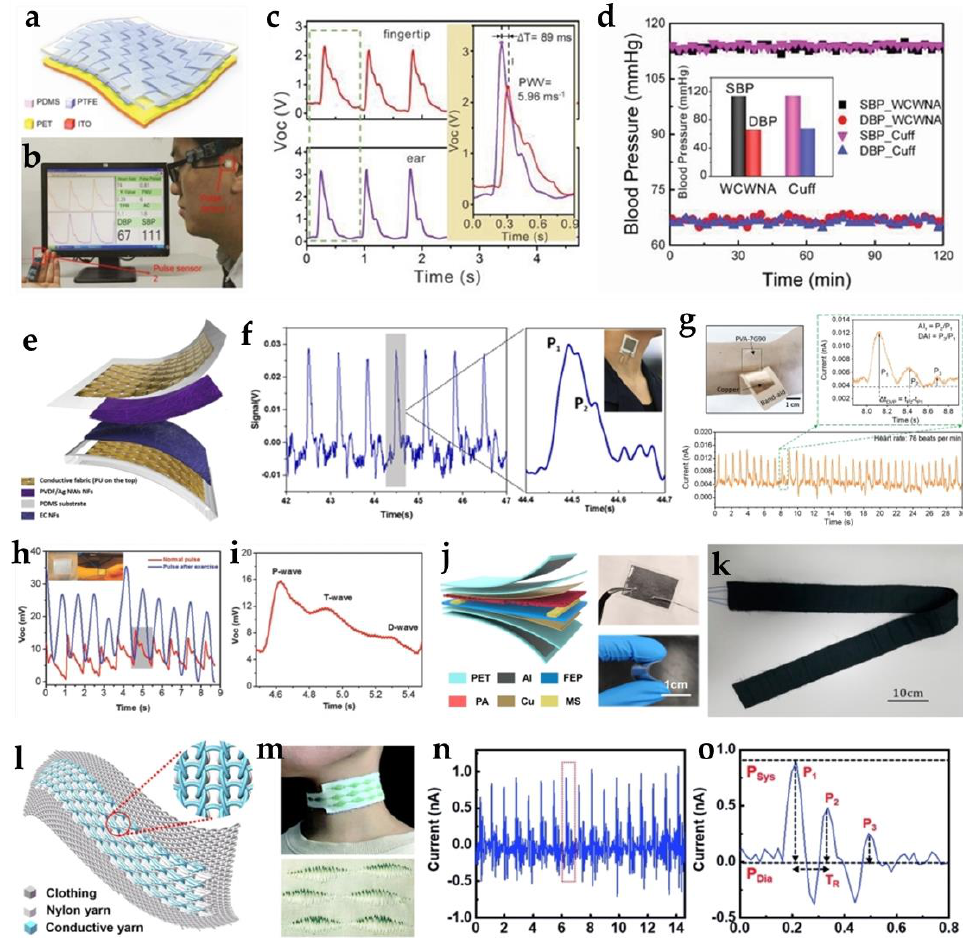
Figure 3. Applications of wearable TENG − based biosensors for cardiology. ( a ) Schematic illustra- tion of the flexible weaving-constructed self-powered pressure sensor. ( b ) Photograph showing the sensor system with two pulse sensors on the human fingertip and ear for PWV and BP detection. ( c ) Corresponding voltage signals from the two pulse sensors. The inset shows an enlarged view of the voltage signal in one pulse cycle. ( d ) Systolic blood pressure (SBP) and diastolic blood pressure (DBP) measurements. Reprinted/adapted with permission from Ref. [78]. 2019, Meng et al. WILEY-VCH. ( e ) Structural design of the pressure sensor textile. ( f ) Real-time detection of the pulse wave of the carotid artery using the sensor textile. (magnified pulse wave consisting of two peaks corre- sponding to the pulse pressure (P1), which is the difference between the systolic (P sys ) and diastolic (P dia ) pressure, and the reflected wave pressure produced from the hand (P2). Reprinted/adapted with permission from Ref. [79]. 2020, Lou et al. American Chemical Society. ( g ) Optical image of the PVA film attached to the human wrist (left). Thirty-second real-time current outputs from the PVA- based TENG device measuring the pulses (right). One pulse period was enlarged (bottom). Re- printed/adapted with permission from Ref. [80]. 2020, Wang et al. WILEY-VCH. ( h ) Real-time arte- rial pulse waves under normal and exercise conditions. The inset is a photograph of a pressure sen- sor attached to a wrist. ( i ) Single-signal waveform extracted from the marked region in ( h ). Re-